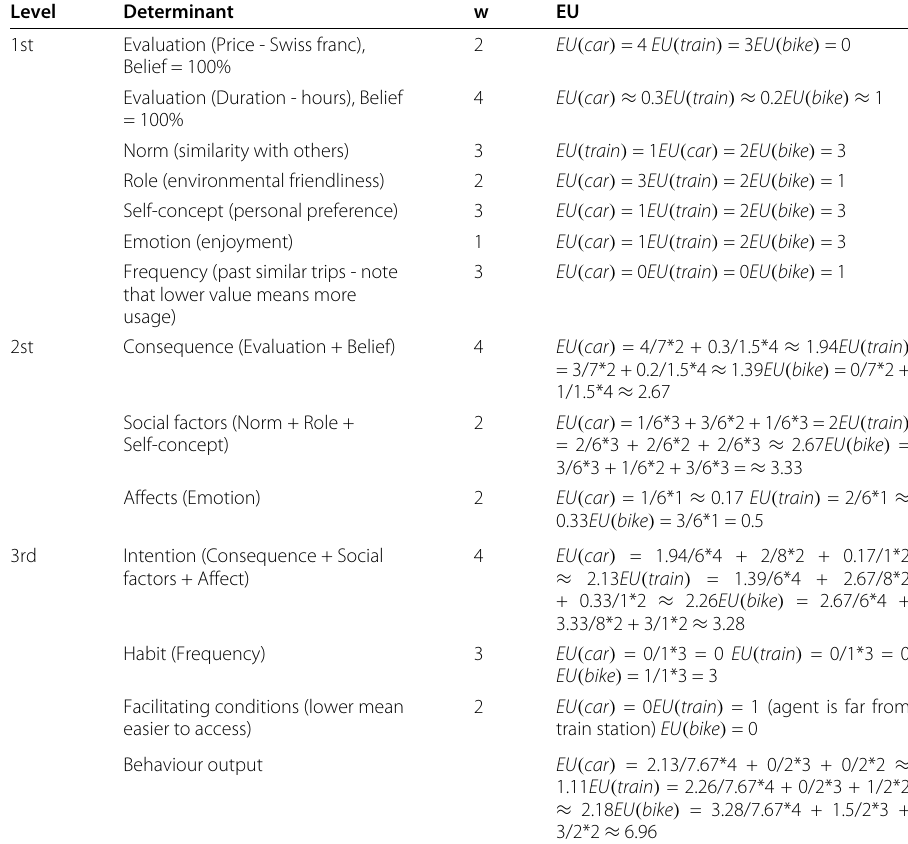
Table 1 Running example of an agent’s decision-making for a 18km-journey from Sion to Sierre/Siders. Note that the expected utility is a cost function, i.e. agent prefer lower value